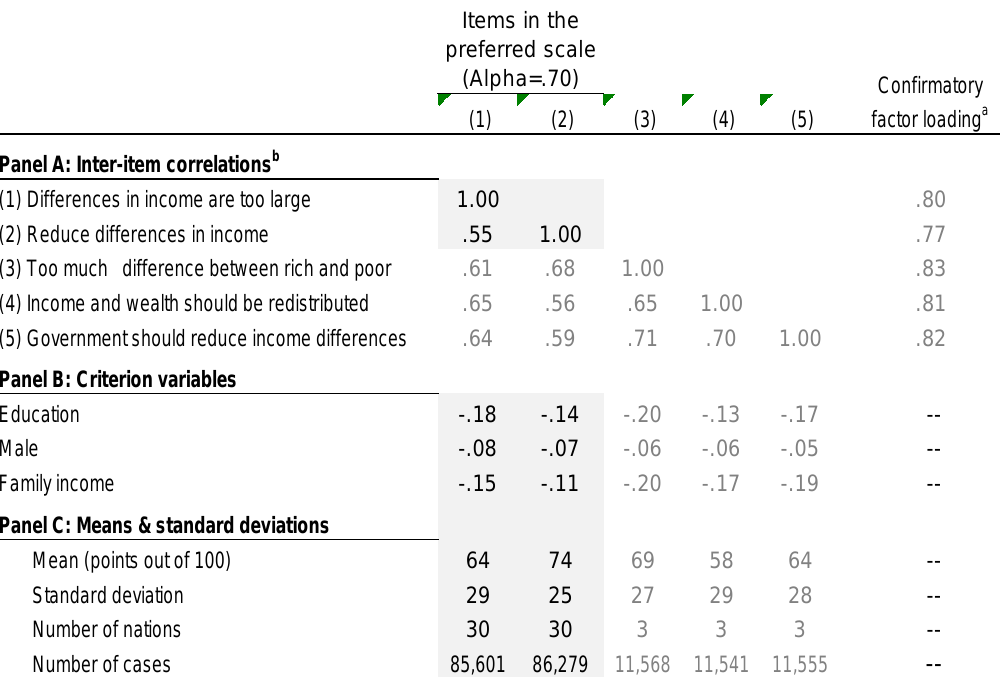
Figure 3. Measurement of redistributive attitudes: Correlations, confirmatory factor loadings, and other statistics. Entries in plain text are based on data for all 30 nations; those in grey text are available only for the 3 never-Communist countries also in the International Survey of Economic Attitudes.